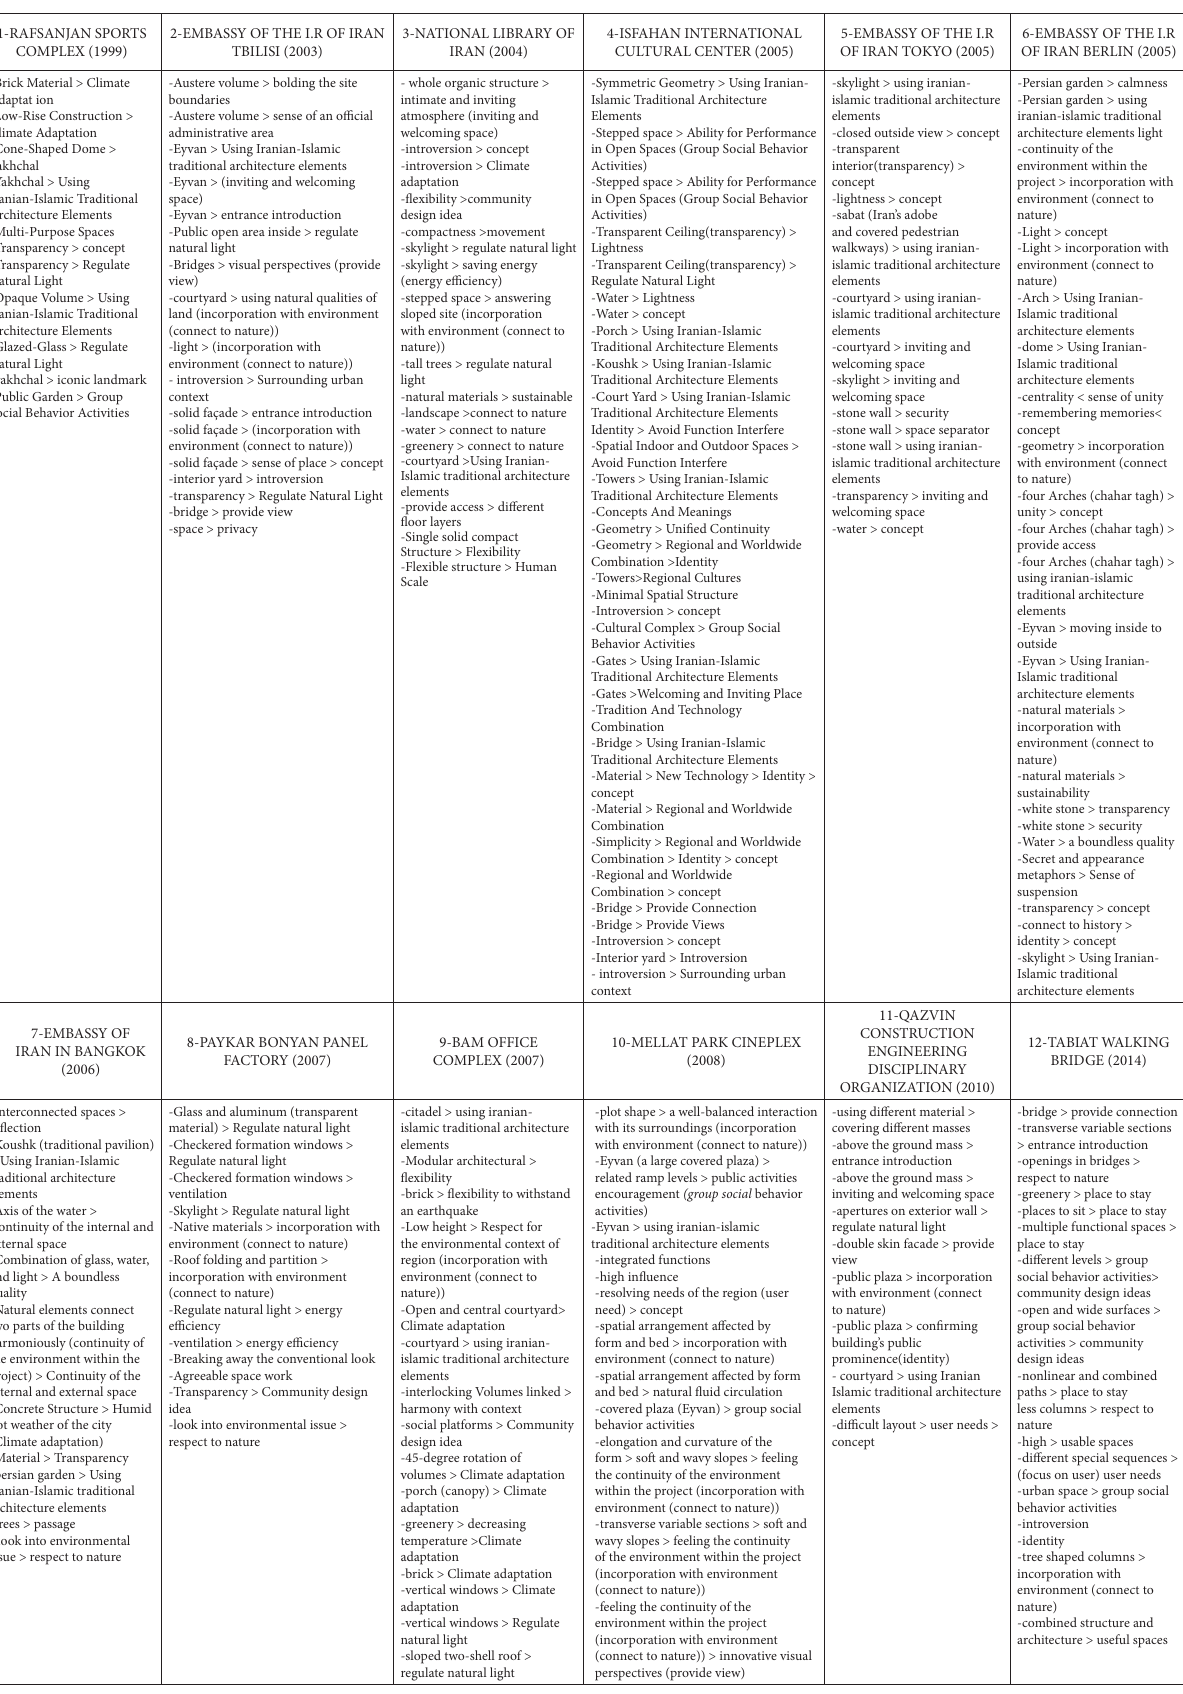
Table 9. Summary of selected project’s codes based on architect’s descriptions and Manuscripts-Based data codes for ATLAS.ti analysis (source: